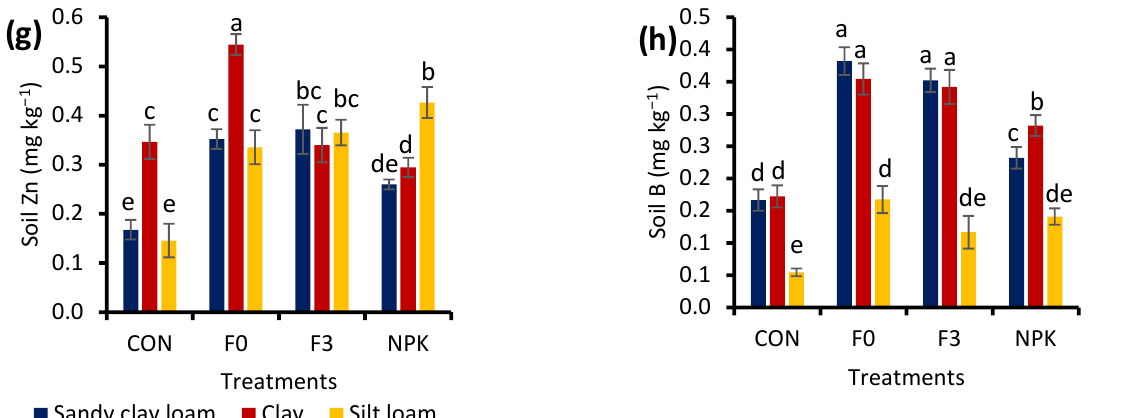
Figure 6. Means (±SE) of the interaction effect of soil types and treatments on total soil ( a ) NH 4 ( b ) P, ( c ) K, ( d ) Ca, ( e ) Mg, ( f ) Cu, ( g ) Zn, and ( h ) B contents. Within the same chart, means followed by the same letter(s) are not significantly different ( p > 0.05) from one another using Tukey’s test. Means were taken across the three planting cycles.